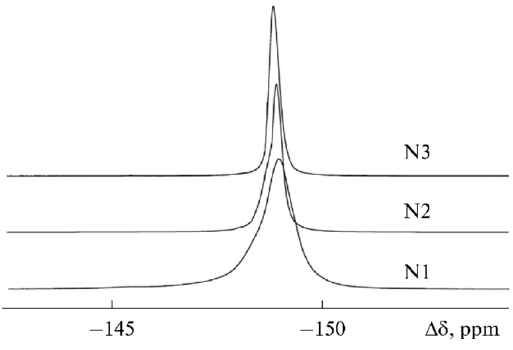
Figure 24. 19 F NMR spectra of samples 1–3 [58].